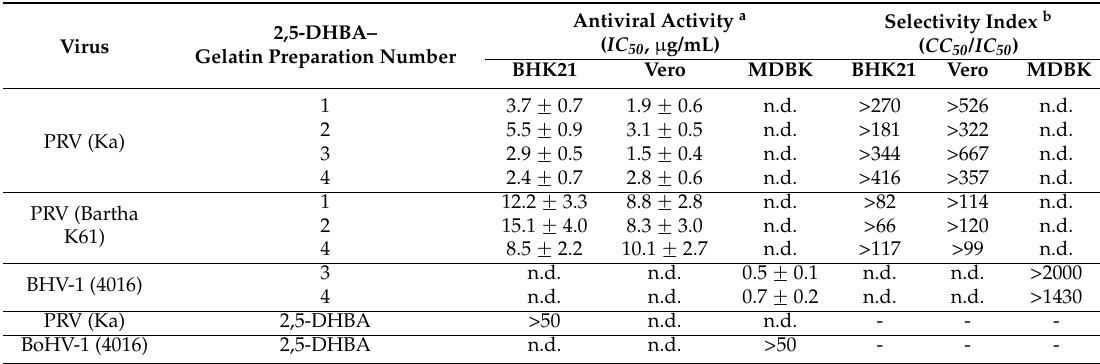
Table 2. Antiviral activity of 2,5-DHBA–gelatin conjugate against pseudorabies virus (PRV) and bovine herpes virus type 1 (BoHV-1).